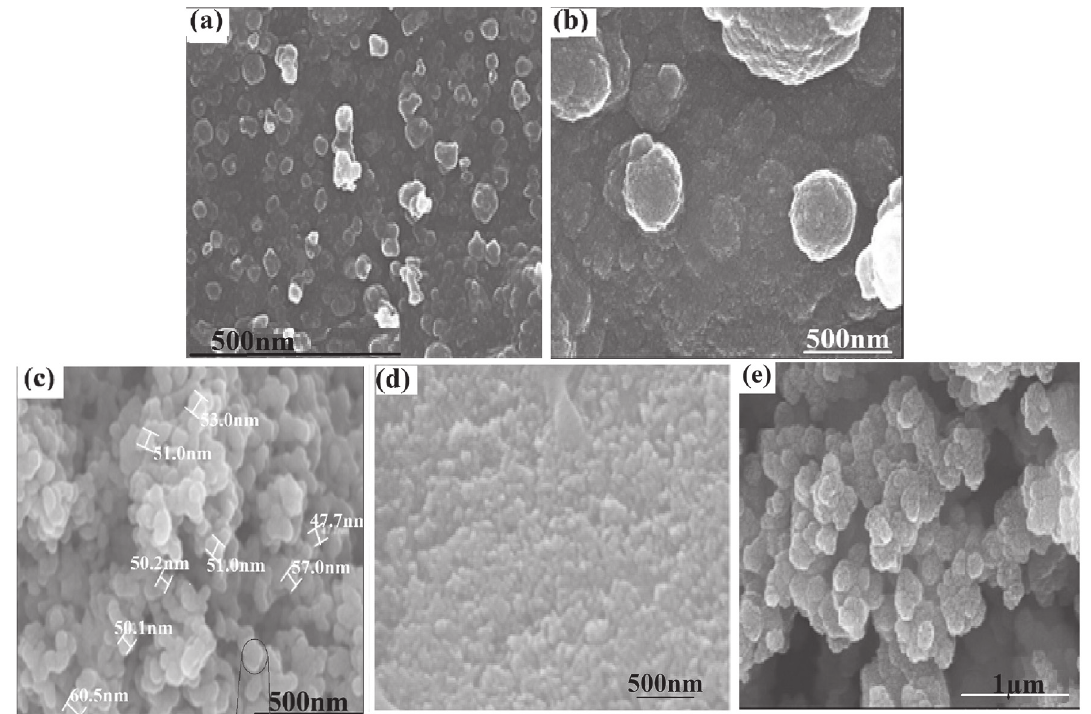
S nanoparticles, (d) CdS nanoparticles, and (e) PPy/(Ag 2